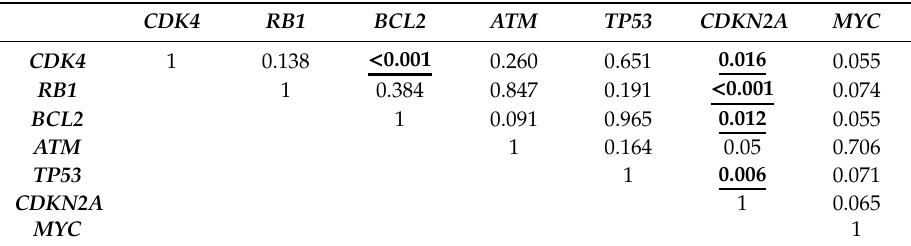
Table 2. Correlation between the analyzed gene